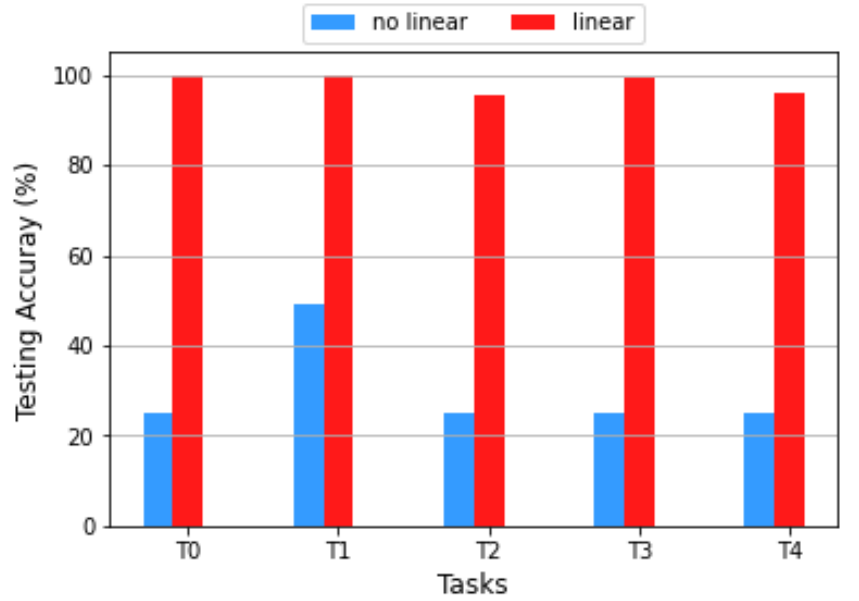
Figure 5. The experimental results of the proposed method with the pre-training linear layer and the method without the pre-training linear